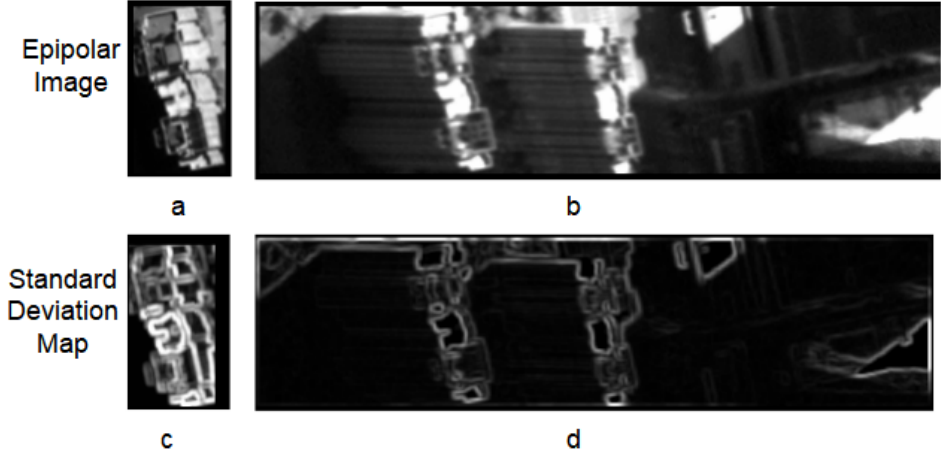
Figure 5. Epipolar image blocks and their standard deviation maps. ( a ) backward image block; ( b ) forward image block; ( c , d ) standard deviation maps of image blocks ( a , b ). Based on the standard deviation maps, we use the gray difference to measure the simi- larity between the backward image and the forward image. The gray difference similarity is measured as the absolute gray difference between the template and the searched image, as shown in Equation (2), where g S is the searched pixel value with x parallax p; w , h i + pj is the template window size; g T is the pixel value of the template window, respectively. i + j The parallax p with the smallest gray difference sum is regarded as the matched